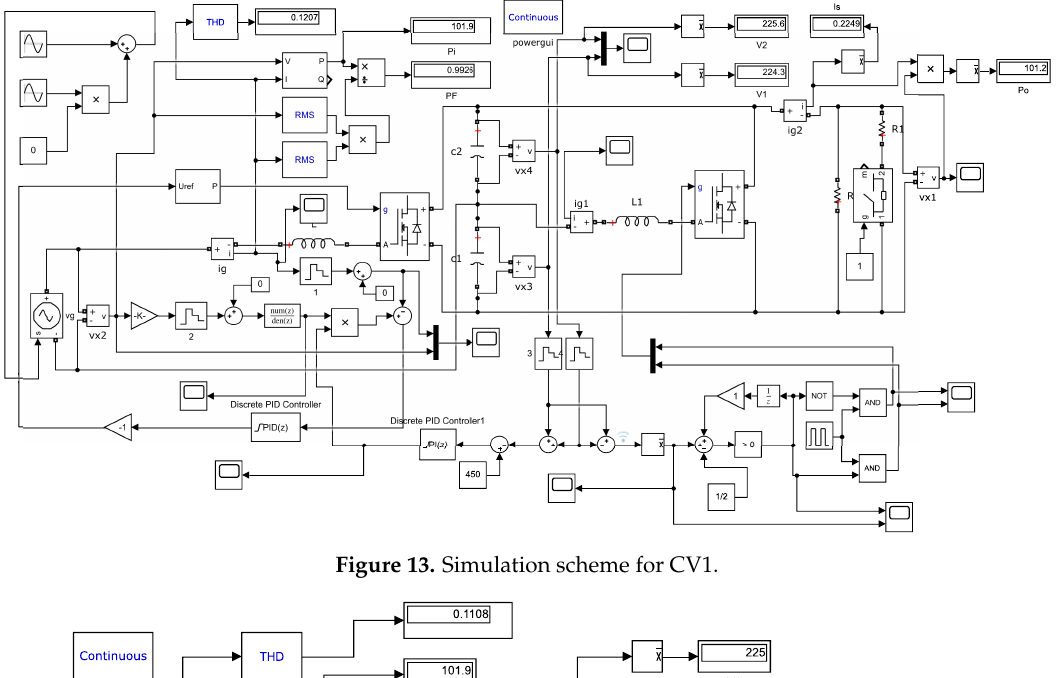
Figure 13. Simulation scheme for CV1.